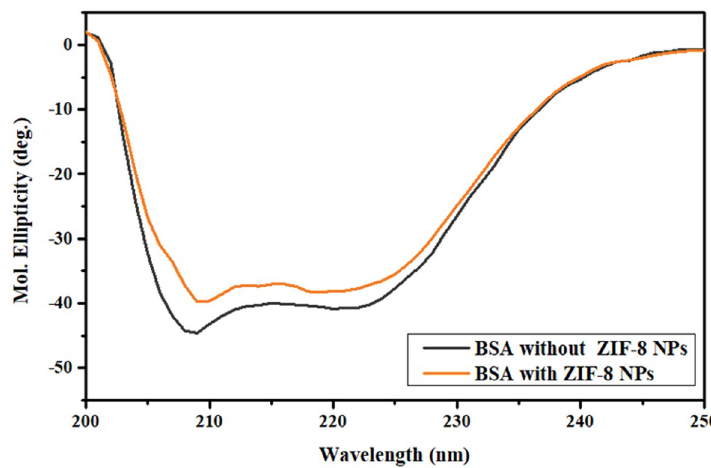
Figure 6. Far UV-CD spectra of BSA in presence and absence of ZIF-8 NPs.